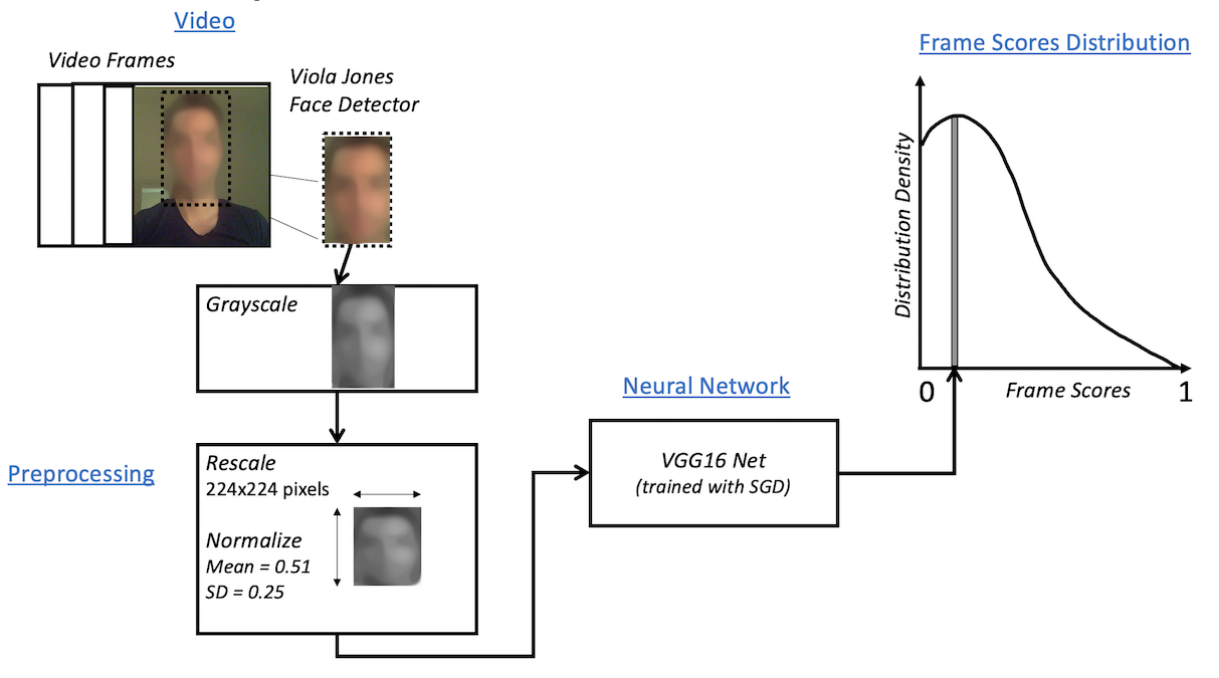
Figure 1. The preprocessing pipeline for the input videos. Faces are extracted, greyscaled, and normalized. Then, each frame in the video is assigned a probabilistic classification assignment from 0 to 1 representing the degree of hypomimia. Thus, each video is represented by a probability distribution of frame scores. SGD: stochastic gradient descent.